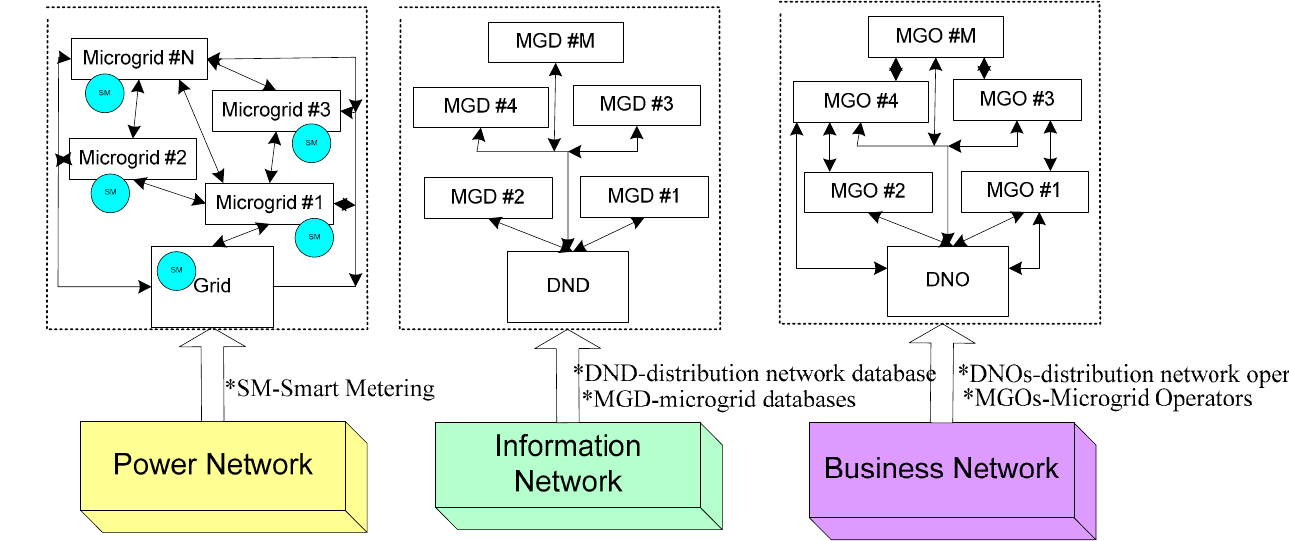
Figure 13. Structure of distribution network for peer-to-peer (P2P) energy trading. Table 3. Recent studies of Blockchain for energy